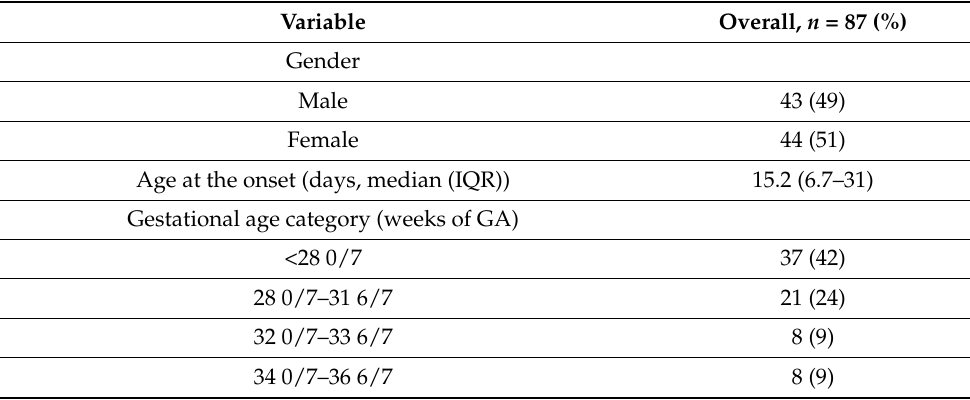
Table 2. Demographic and clinical characteristics of included